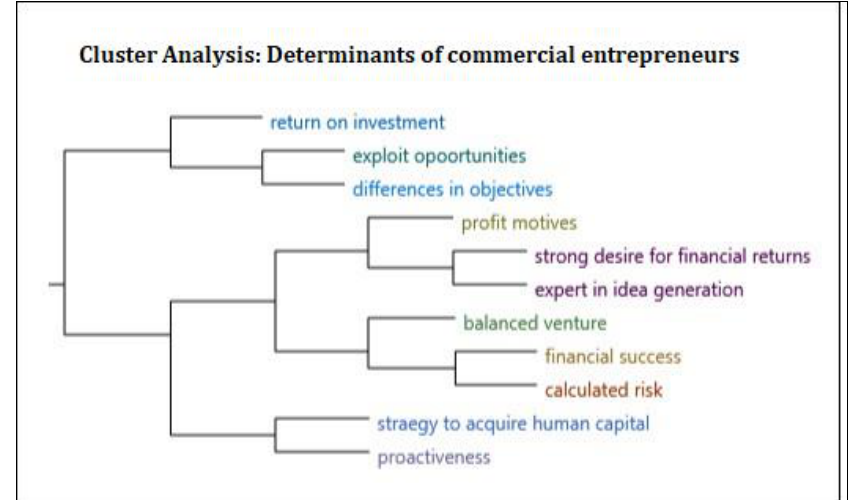
Figure 4.2. Cluster Analysis extracted from Nvivo based on